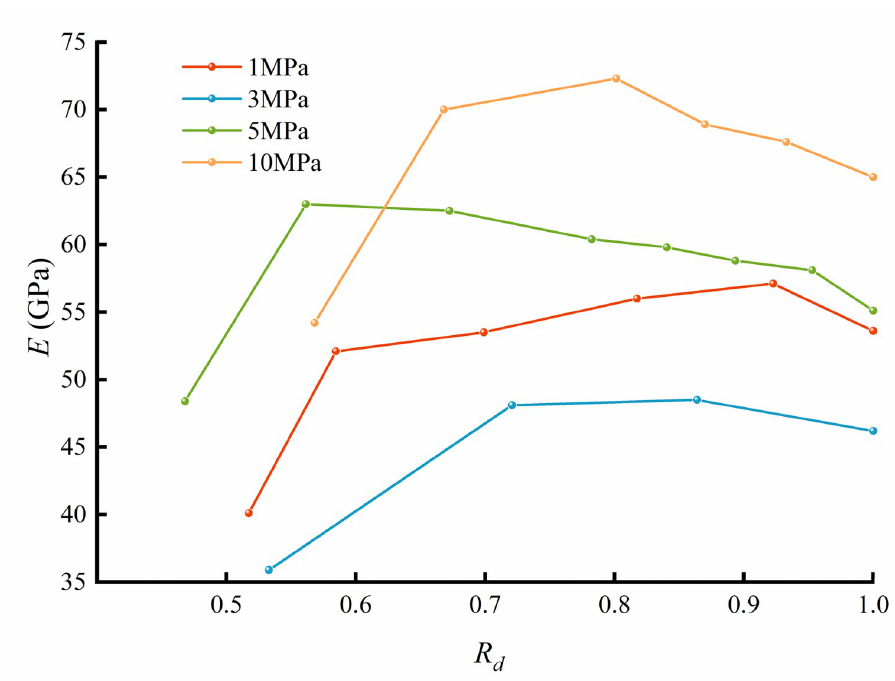
Fig 8. The rock elastic modulus results from the multilevel loading creep